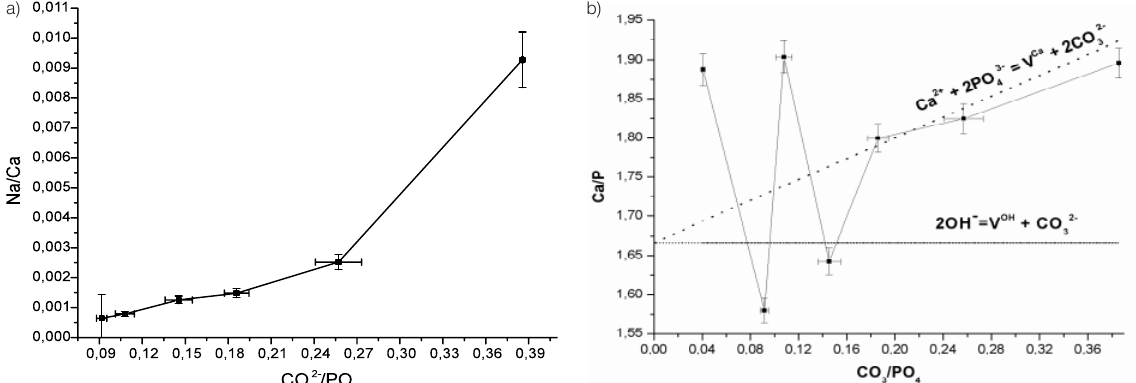
Figure 5. a) Chemical composition of Na-CHA: CO 32- /PO 43- vs . Na/Ca, b) experimental plot of Ca/P vs. CO 32- /PO 43- in comparison with two substitution models.